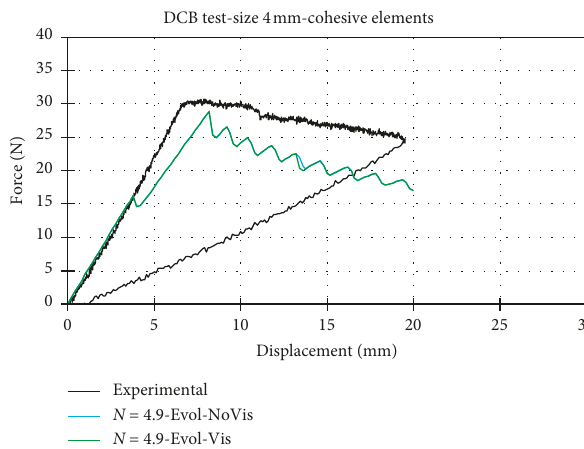
Figure 14: DCB test: cohesive element approach (element size 4mm).